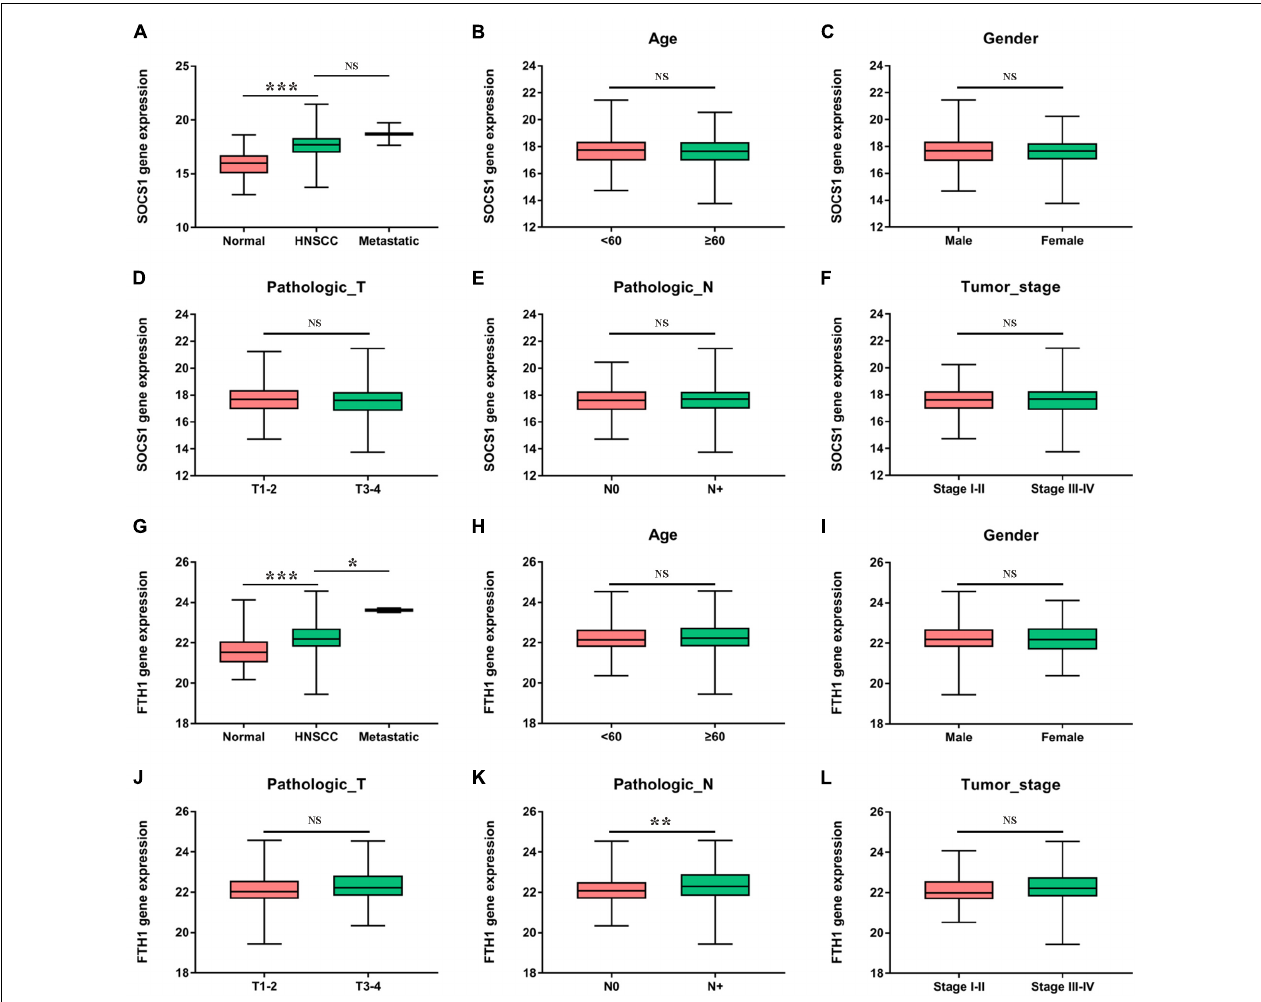
FIGURE 4 | Clinical significance of SOCS1 and FTH1 gene expression in HNSCC. (A) SOCS1 levels were significantly higher in HNSCC compared with those of normal tissues ( t = 10.74, p < 0.001). (B–F) There was no statistically significant difference between SOCS1 levels and age, sex, pathological T stage, pathological N stage, or tumor stage. (G) The levels of FTH1 were significantly higher in HNSCC compared with those in normal tissues ( t = 4.976, p < 0.001) and were significantly associated with metastatic sites ( t = 2.569, p = 0.0105). (H–L) FTH1 levels were significantly higher in HNSCC with node metastasis compared with HNSCC without such metastasis ( K , t = 2.764, p = 0.0060), and there was no significant difference between FTH1 levels and age, sex, pathological T stage, or tumor stage.